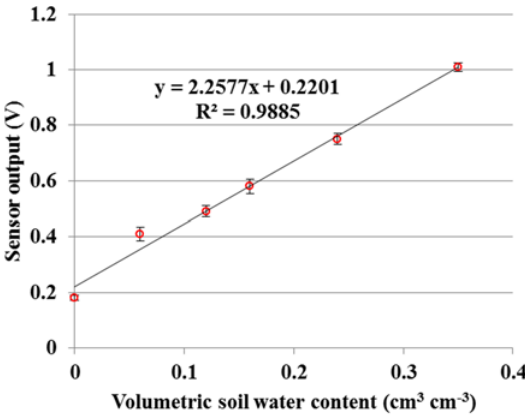
Figure 5. The relationship between volumetric soil water content (VSWC) and the output of the dielectric sensor.